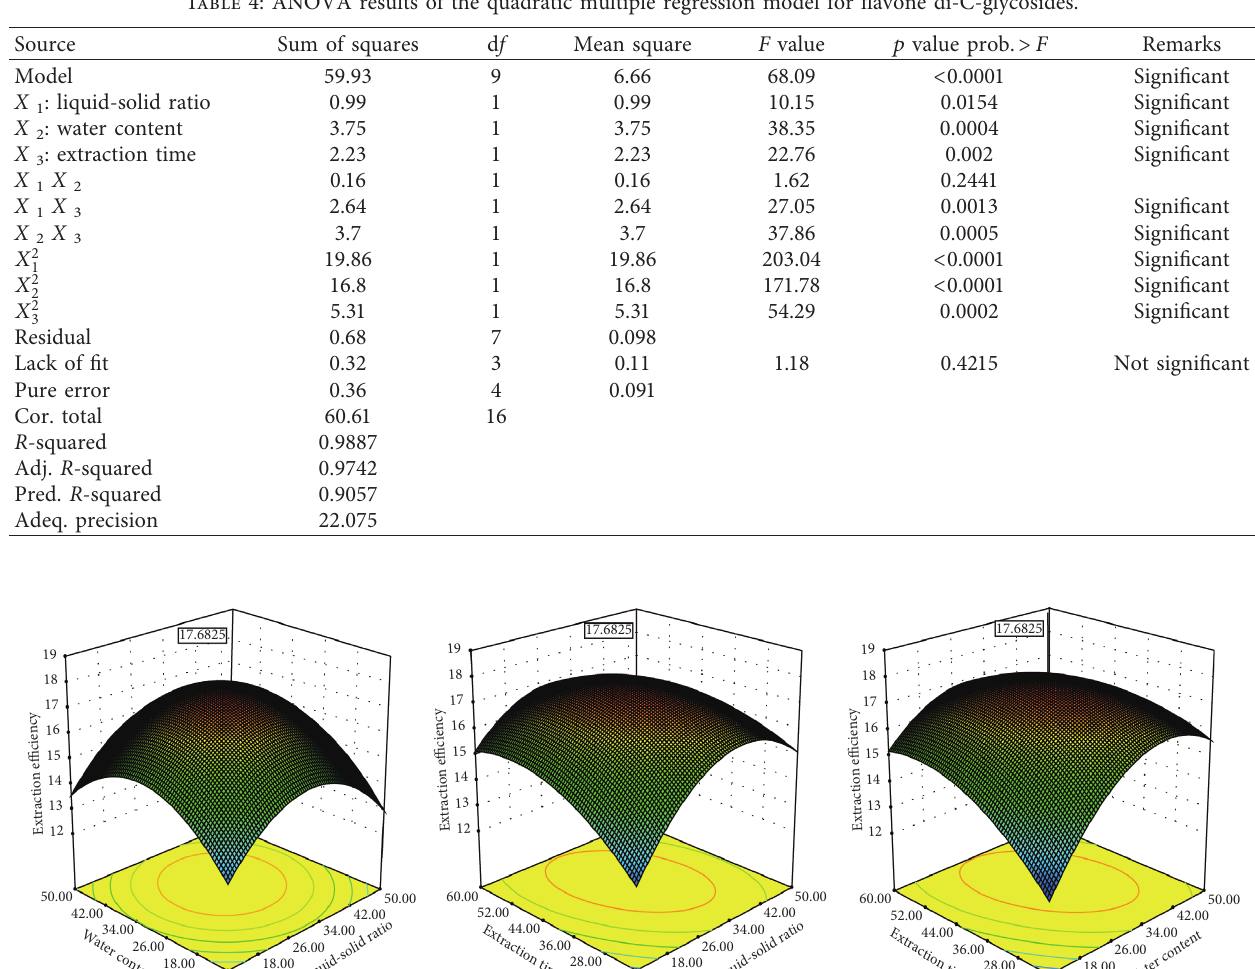
Table 4: ANOVA results of the quadratic multiple regression model for flavone di-C-glycosides.